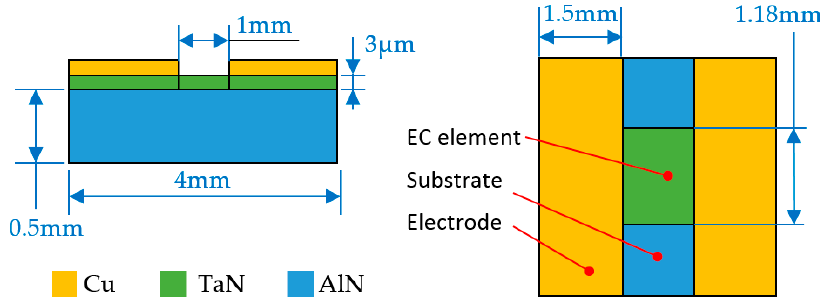
Figure 9. Three dimensions and material of EC element under insensitivity analysis.